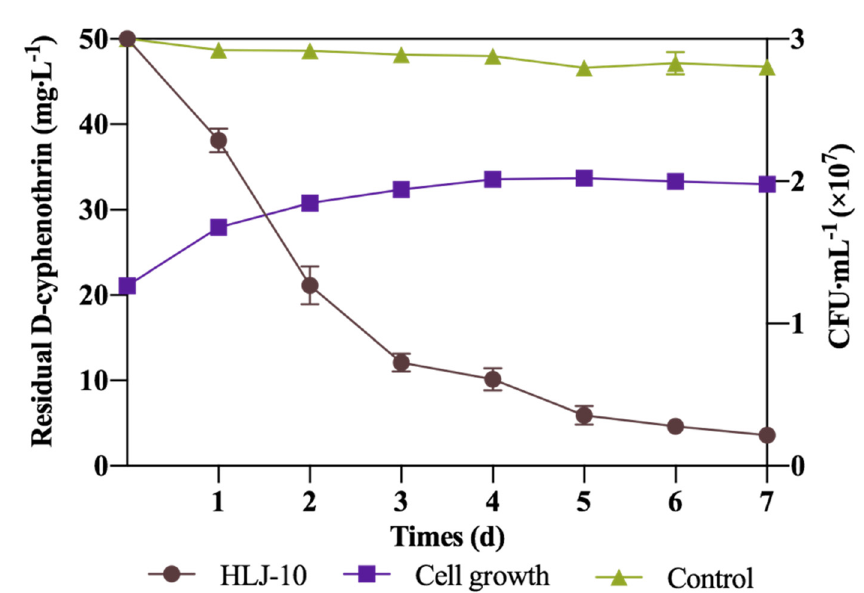
Figure 2. Utilization of D-cyphenothrin during growth of Staphylococcus succinus HLJ-10. Error bars indicate standard deviation of three replicates.